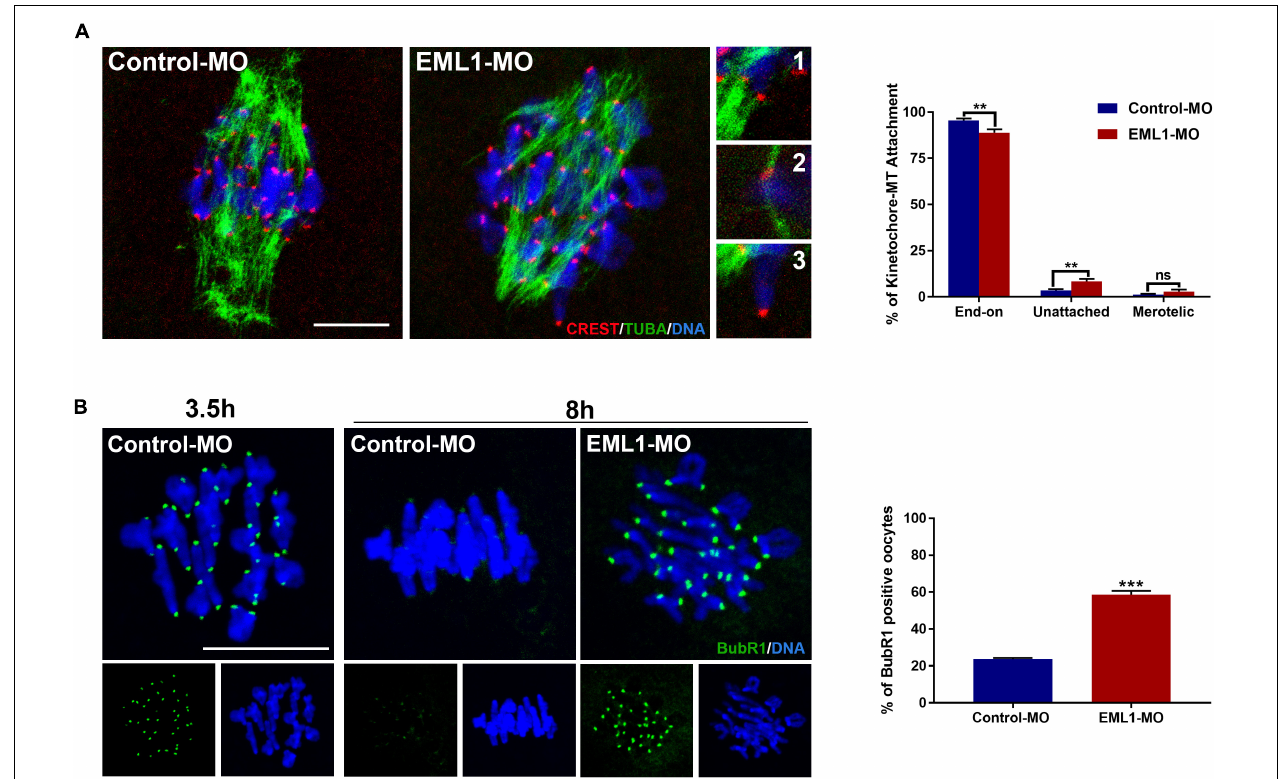
FIGURE 6 | Increased kinetochore-microtubule attachment error and abnormal activation of spindle assembly checkpoint in EML1-Knocked down MI-stage oocytes. (A) Assessment of kinetochore–microtubule attachments in MO-injected oocytes that were matured in vitro for 8 h by IF staining. Microtubules, kinetochores, and chromosomes were stained in green, red, and blue, respectively. Representative images of end-on (1), unattached (2), and merotelic (3) attachments are shown. A total of 349 and 247 attachments were assessed, respectively, in the Control-MO and EML1-MO treated oocytes. ** P < 0.01, ns denotes no significant difference. compared with the Control-MO and EML1-MO group. (B) Assessment of the activation of SAC in MO-injected oocytes that were matured in vitro for 8 h by IF staining of BubR1. Oocytes that were normally matured in vitro for 3.5 h served as positive control. BubR1 and chromosomes are stained in green and blue, respectively. *** P < 0.005, compared with the EML1-MO